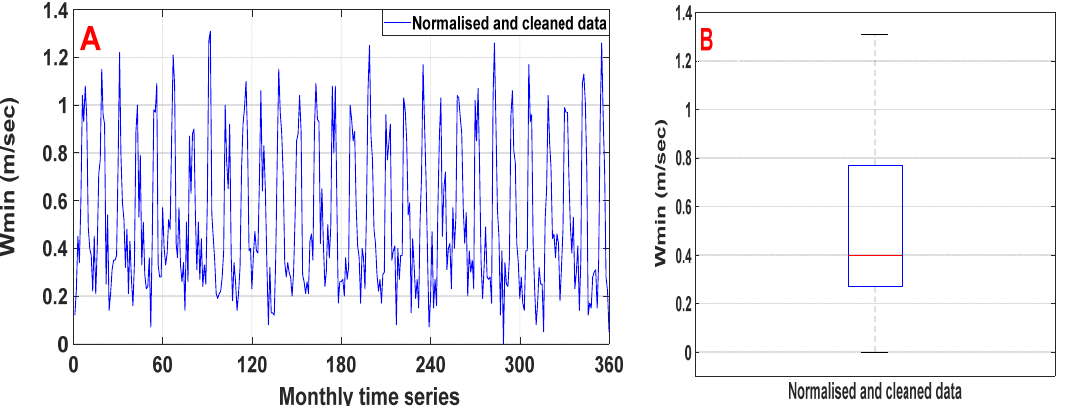
Figure 3. Normalised and cleaned wind speed minimum data: ( A ) monthly time series and ( B ) boxplot data.